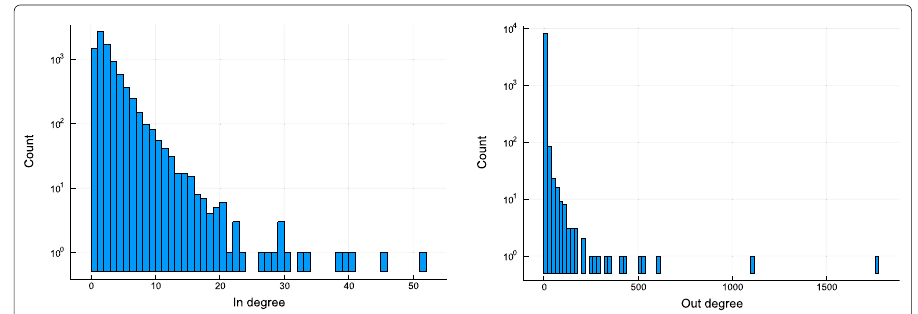
Fig. 3 PyPI degree distributions. In and out degree distributions for the PyPI package ecosystem